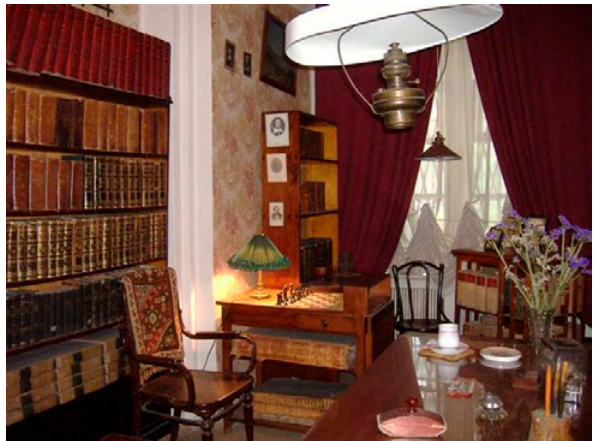
Figure 5. Mendeleev’s Apparatus for Measuring Gas Densities. Pho- tograph courtesy Roger